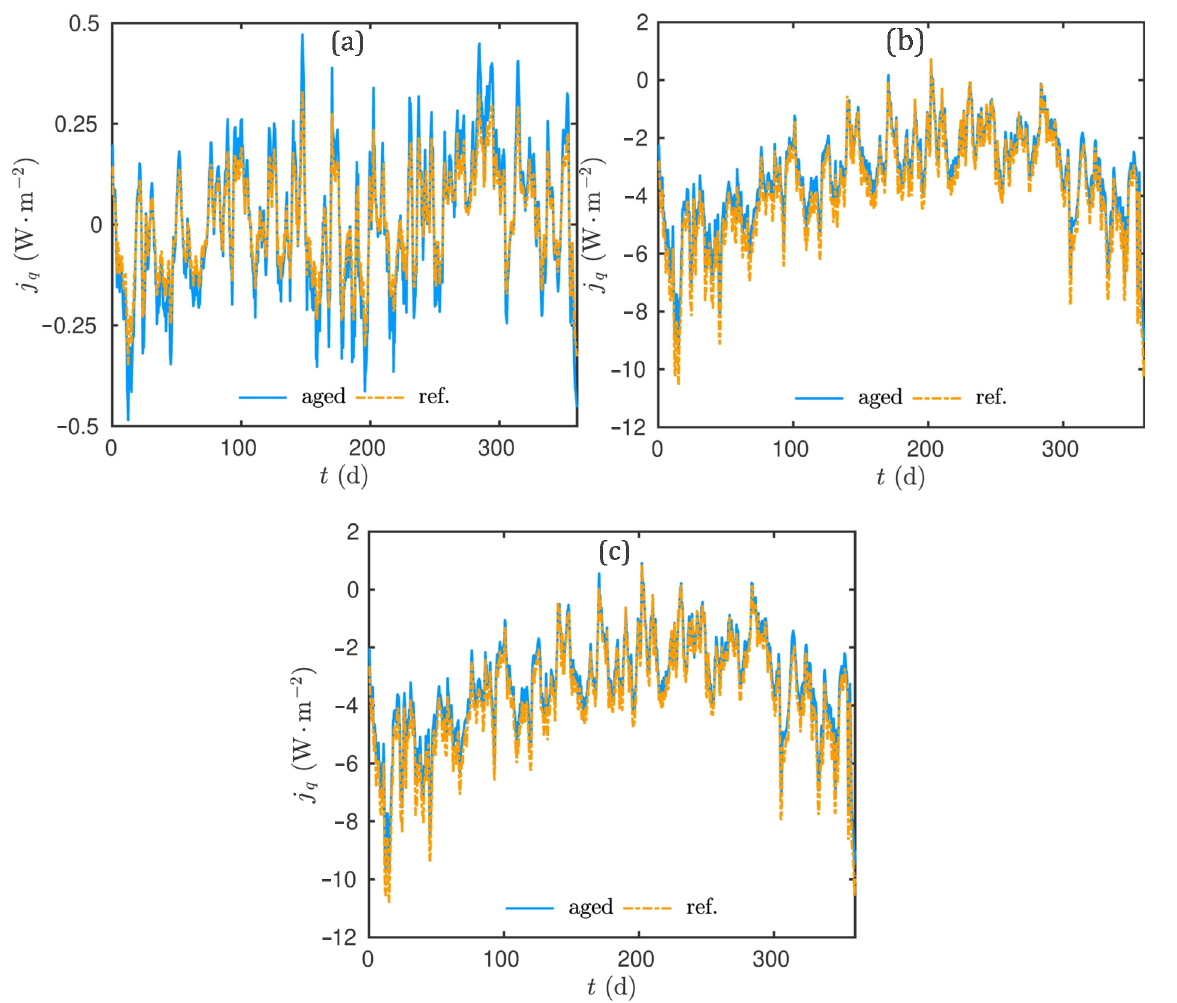
Figure 17. Time evolution of the ( a ) latent, ( b ) sensible and ( c ) total heat flux inside the wall.